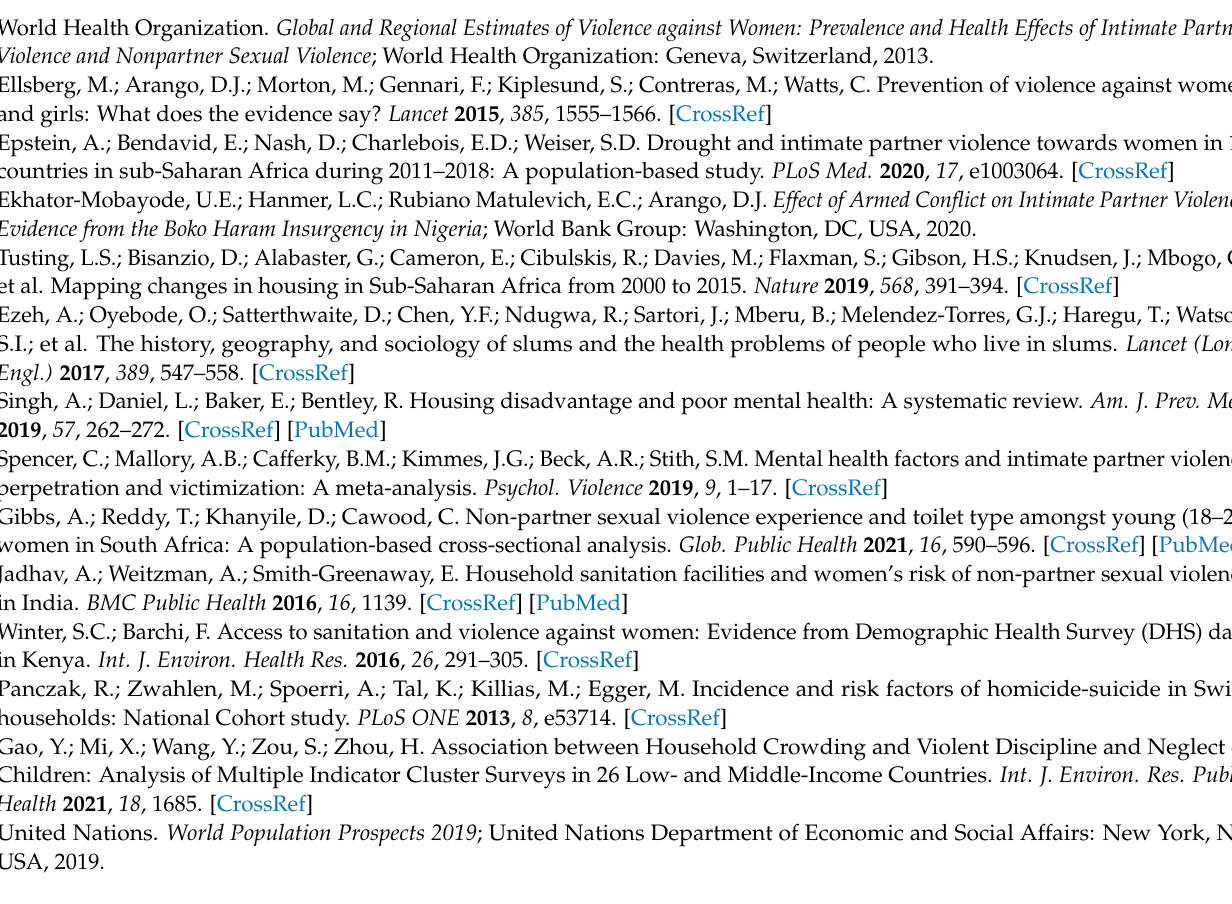
Table S9: Mutually adjusted associations of inadequate living conditions and its characteristics with intimate partner